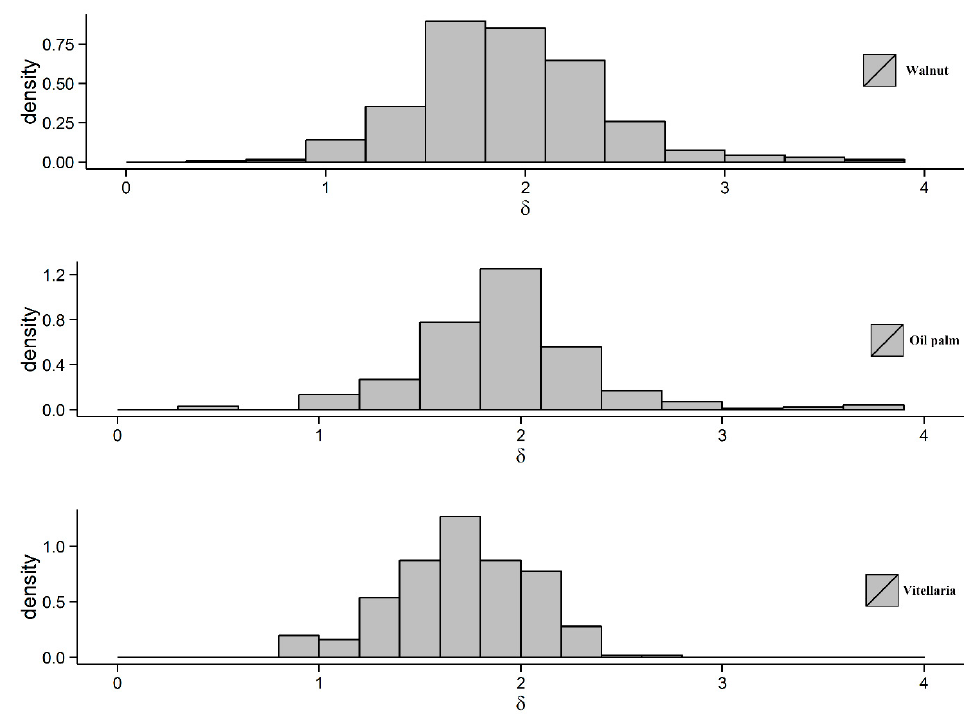
Figure 14. Distributions of parameter δ for different trees types obtained with model f 3 ( s ).